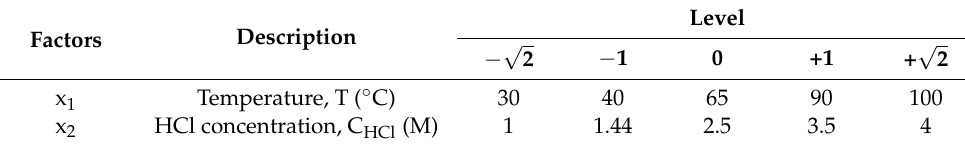
Table 4. Factors and levels of the experimental design.